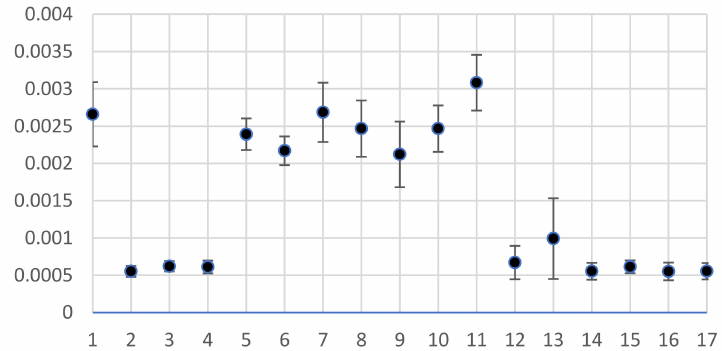
Figure 5. The ratio Mg/Ca in shells of mussels along the African coast.